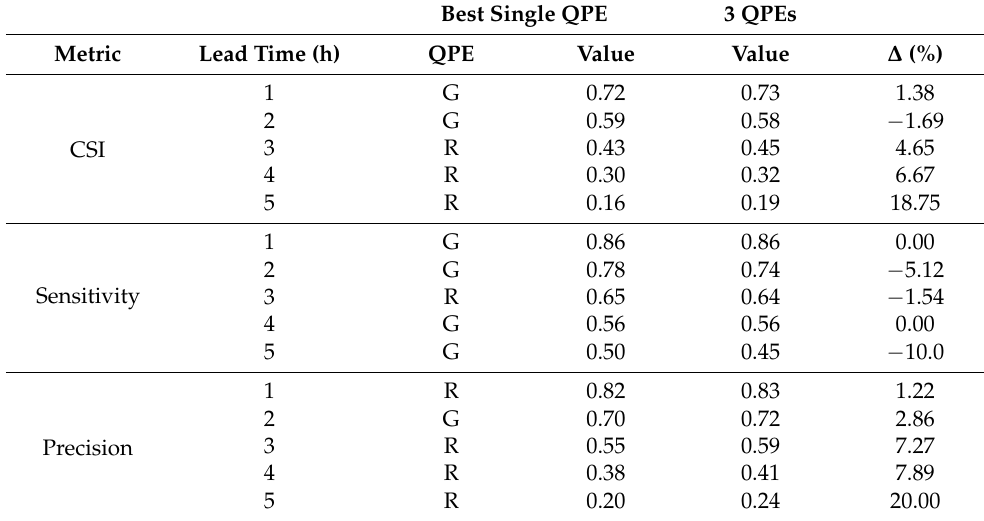
Table 5. Summary of mean performance gains—metrics related to contingency analysis. Best Single QPE 3 QPEs Metric Lead Time (h)